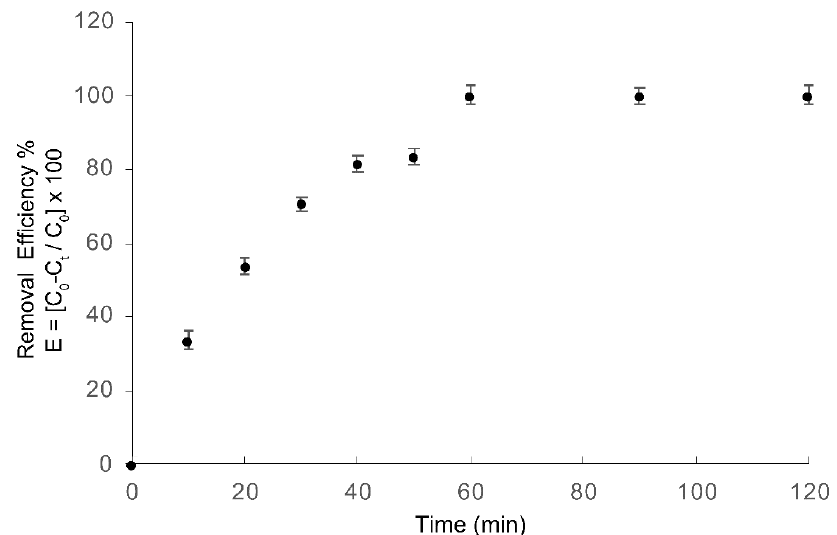
Figure 6. COD removal efficiency for azo dye Carmoisine (5 ppm) as a function of treatment time. ( • ) EO–PAP sequenced treatment (30 min of EO + 30 min of PAP). The pH of the sample was adjusted to